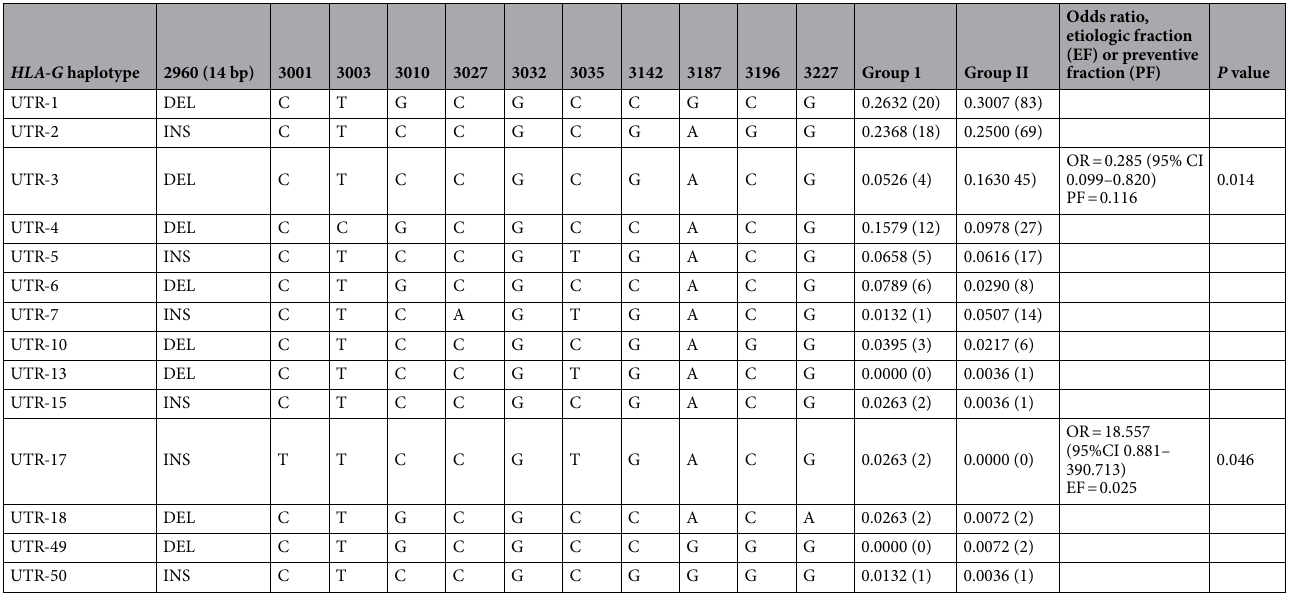
Table 3. Frequency and absolute number of the HLA-G 3 ′ UTR haplotypes observed in patients with AIDS exhibiting CMV retinitis (CMV-R: Group I) and in patients with AIDS without CMV-R (Group